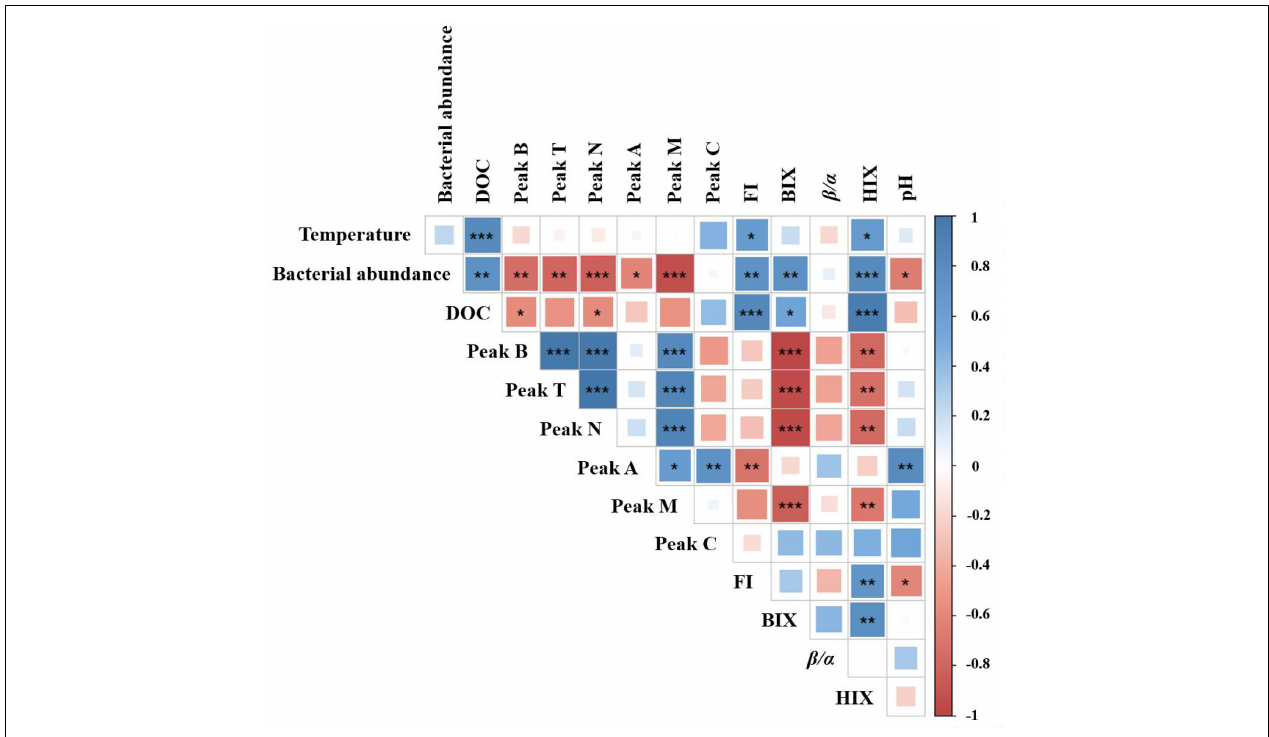
FIGURE 5 | Correlation analysis between DOM-associated parameters and temperature and pH potential impact. Pearson’s correlation coefficients are shown by square colors and sizes. *, **, and *** represent significance degrees at p < 0.05, p < 0.01, and p < 0.001, respectively. A positive connection is represented by blue, whereas a negative correlation is shown by